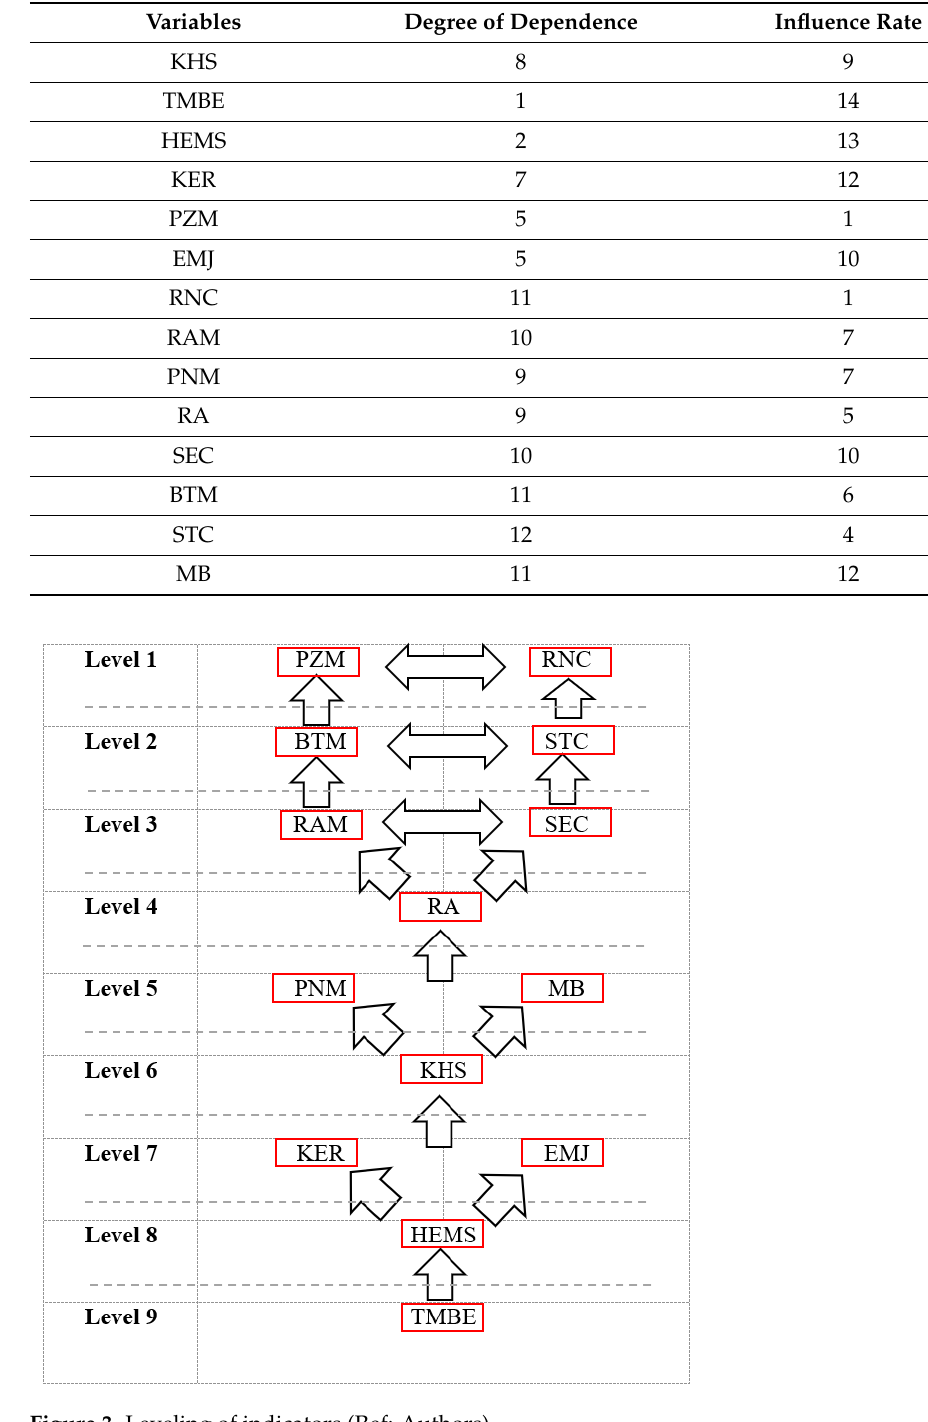
Figure 3. Leveling of indicators (Ref: Authors). Low-level variables are the most influential (TMBE and HEMS) and higher-level variables are the most influenced (PZM and